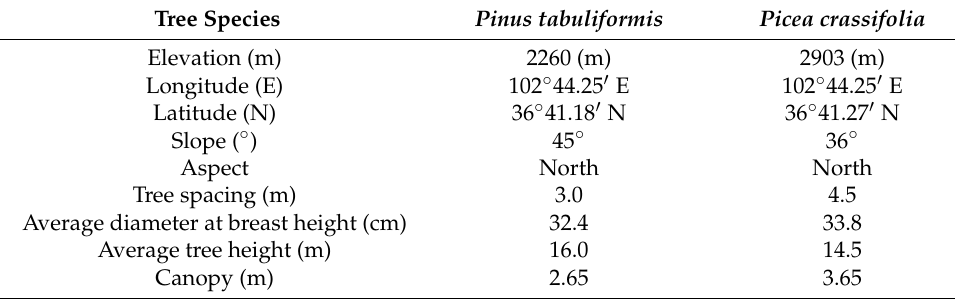
Table 1. Information of tree ring sampling sites in this study.